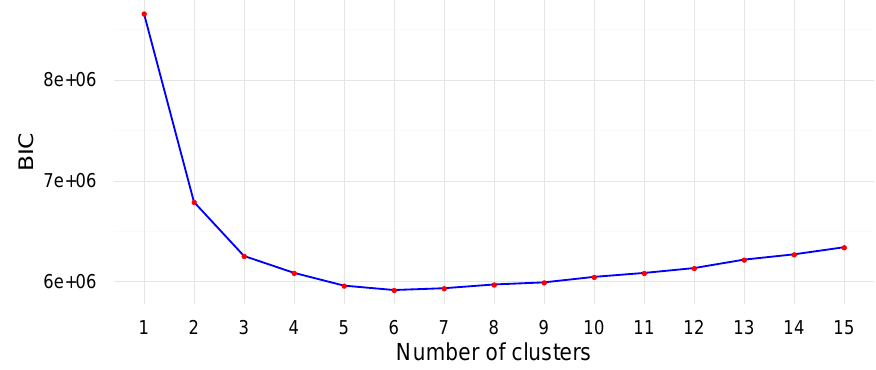
Figure 2. Evolution of Bayesian Information Criterion according to the number of clusters